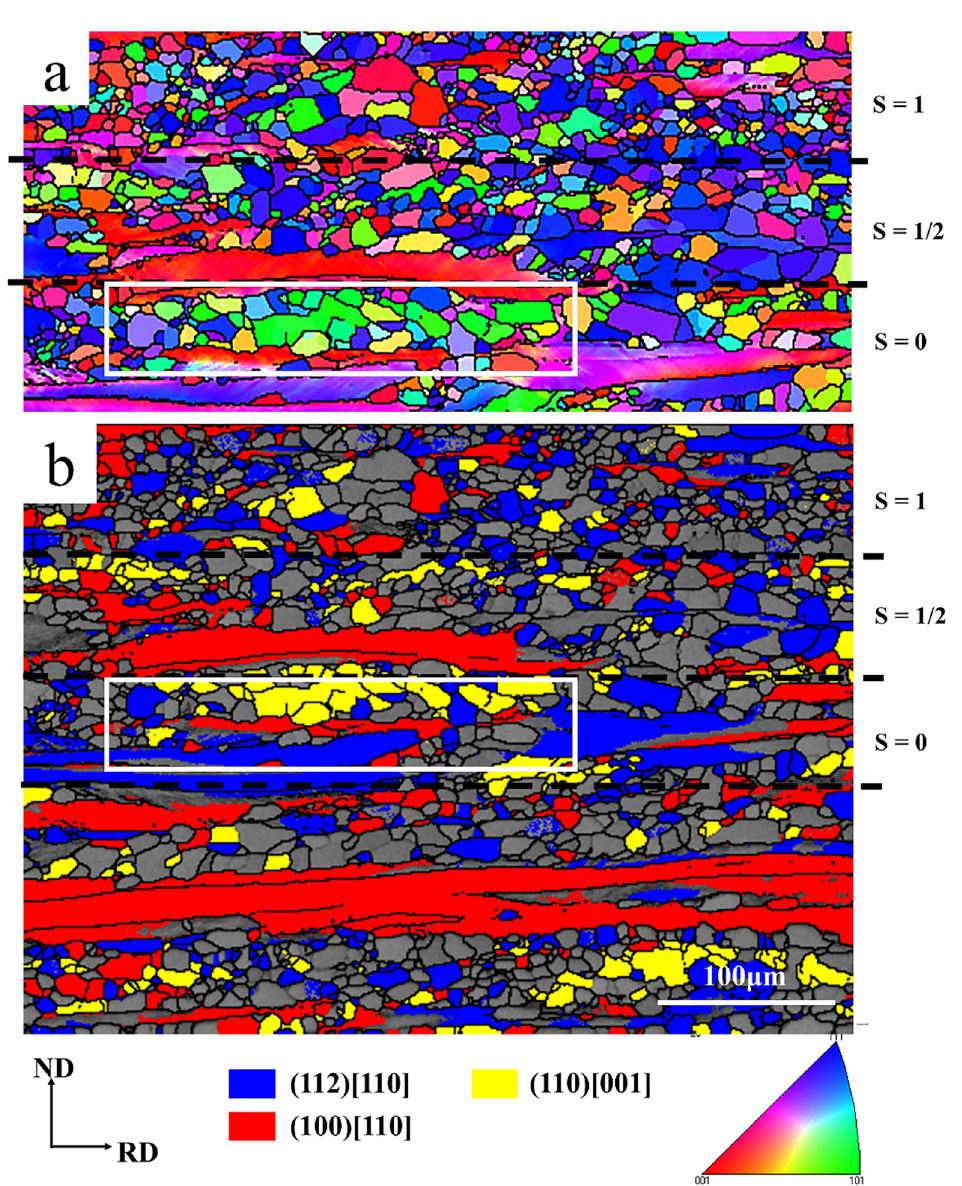
Figure 11. Microstructure and texture of asymmetric-rolled sample after annealing at 650 °C. ( a ) EBSD inverse pole figure map; ( b ) image quality map showing Goss and cube crystals within the deformed matrix.